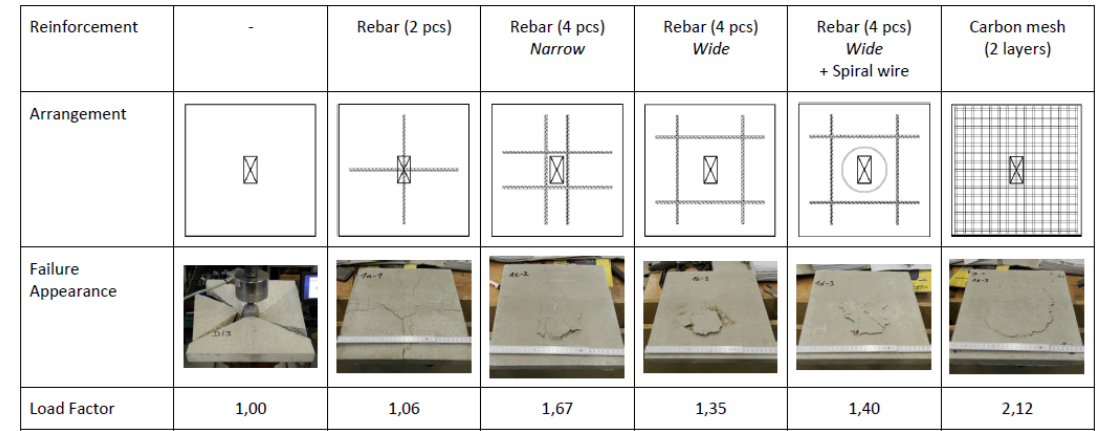
Figure 9. Tests with additional reinforcement. The resistance of the unreinforced concrete forms the reference value. It can be seen from the pictures that the load-bearing capacity is significantly influenced by the crack development. The inserted carbon meshes prevented cracks and a concrete breakout cone could form.